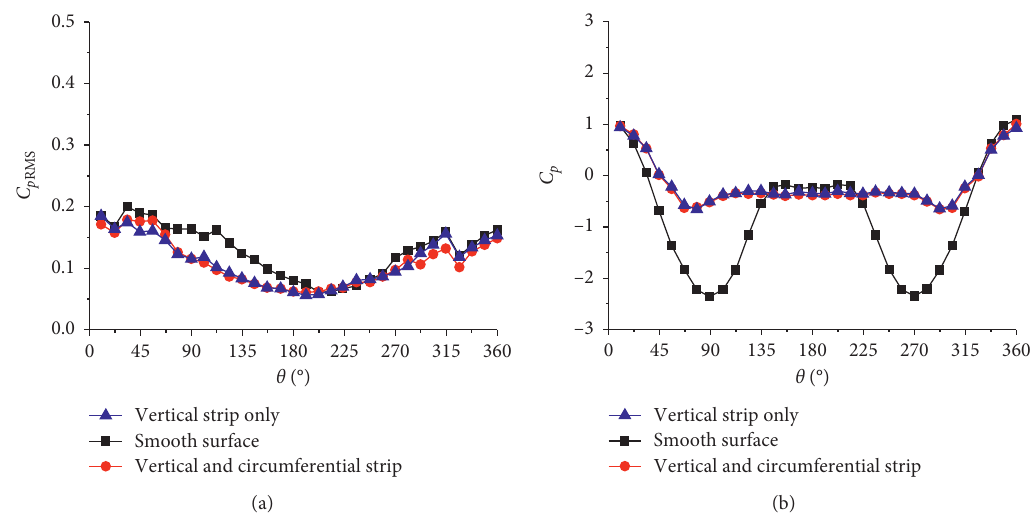
Figure 13: Effects of stiffeners on the wind pressure coefficient: (a) fluctuating wind pressure coefficient and (b) mean wind pressure coefficient.